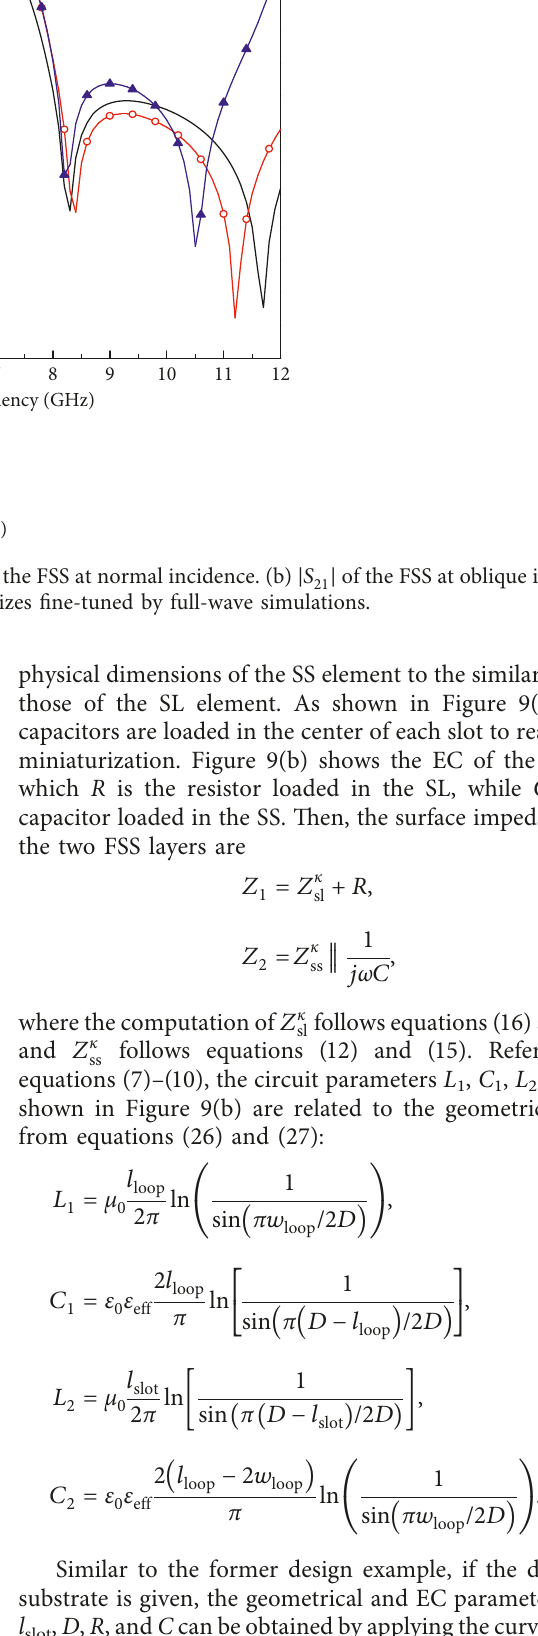
| of the FSS at oblique incidence 21